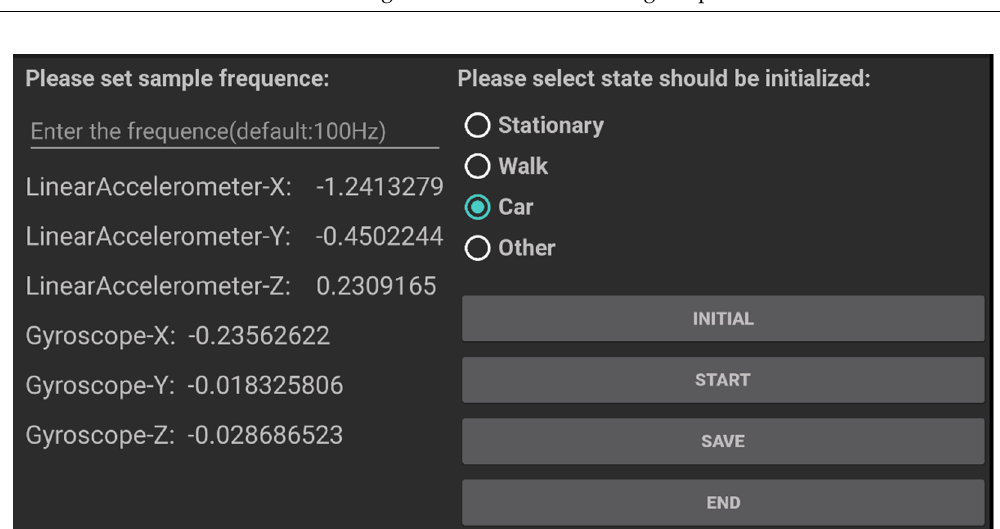
Figure 11. Data collection application.